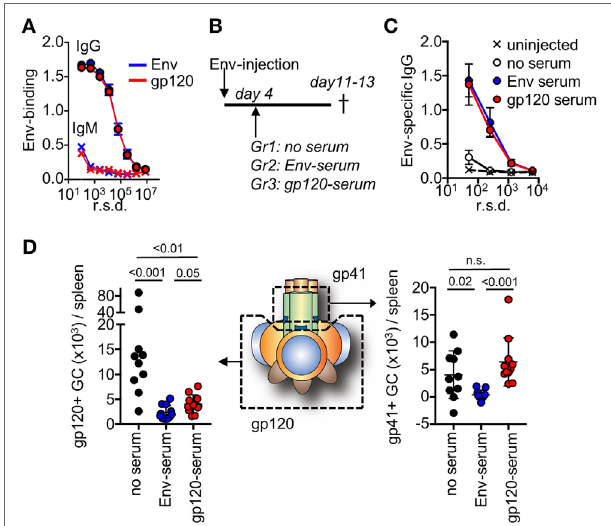
FigUre 4 | After repeated injections with either Env or the subunit gp120, serum was harvested from mice and assessed for binding to Env. (a) Shown is IgG or IgM in serum pre-normalized for Env binding, as assessed by ELISA. (B) Mice ( N = 5–6/group) were injected with Env and anti-Env or anti-gp120 serum was infused at the indicated time point. The mice were terminated on days 11–13 after start of the experiment. Control mice ( N = 4–5/group) did not receive a serum infusion. (c) Assessment of Env-specific IgG by ELISA in serum from respective groups 13 days after injection with Env. (D) Detection of gp120 and gp41-specific germinal center (GC) B cells in groups of mice that had received Env-specific or gp120- specific serum, or no serum on day 4 after the Env injection. Shown is the accumulated data from two separate